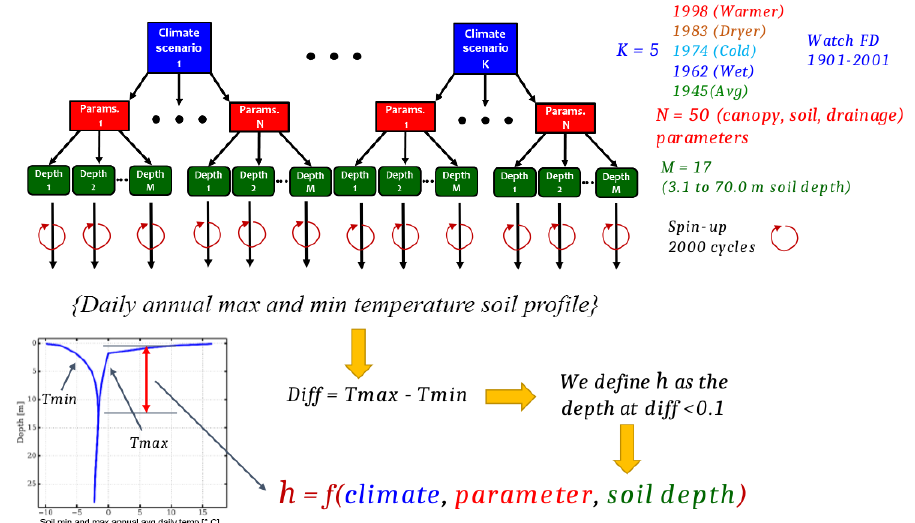
Figure 4. Schematic representation of the model experiment for Experiment 1. The model set-ups are defined as combinations of 5 different climate conditions, 50 randomly selected sets of parameter values within their uncertainty ranges, and 17 different soil configurations. Each model is then run in a spin-up mode for 2000 cycles. The last year of spin-up is taken to compute the daily annual maximum and minimum soil temperature profiles and their difference is computed. The depth at which this difference becomes less than 0.1 is referred to as the “non-oscillation depth” or h T